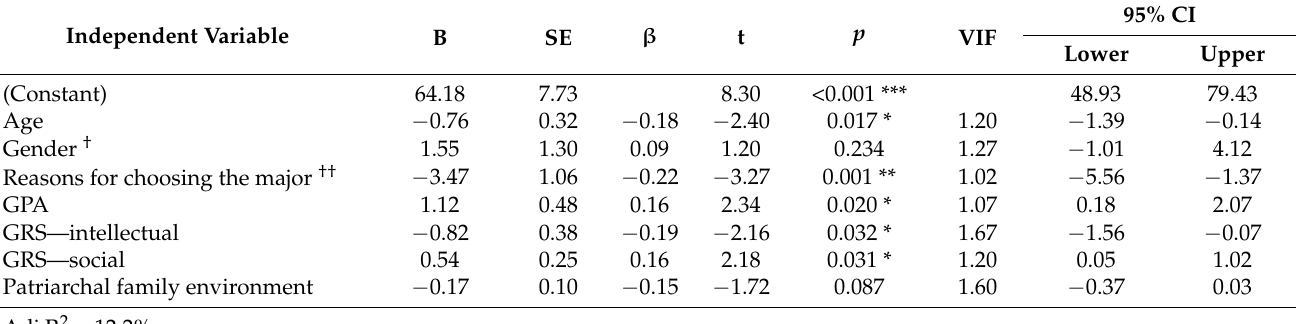
Table 4. Factors influencing major satisfaction ( n =